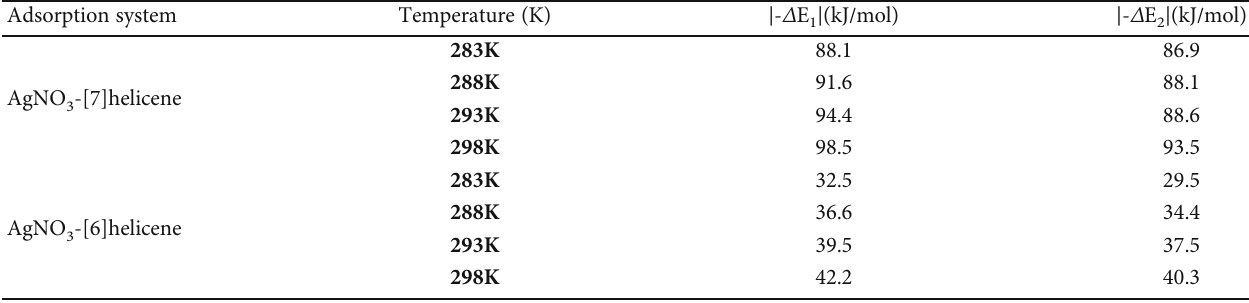
Table 2: Modulus values of the molar adsorption energies |- Δ E helicenes by the silver ions given at 283K, 288K, 293K and